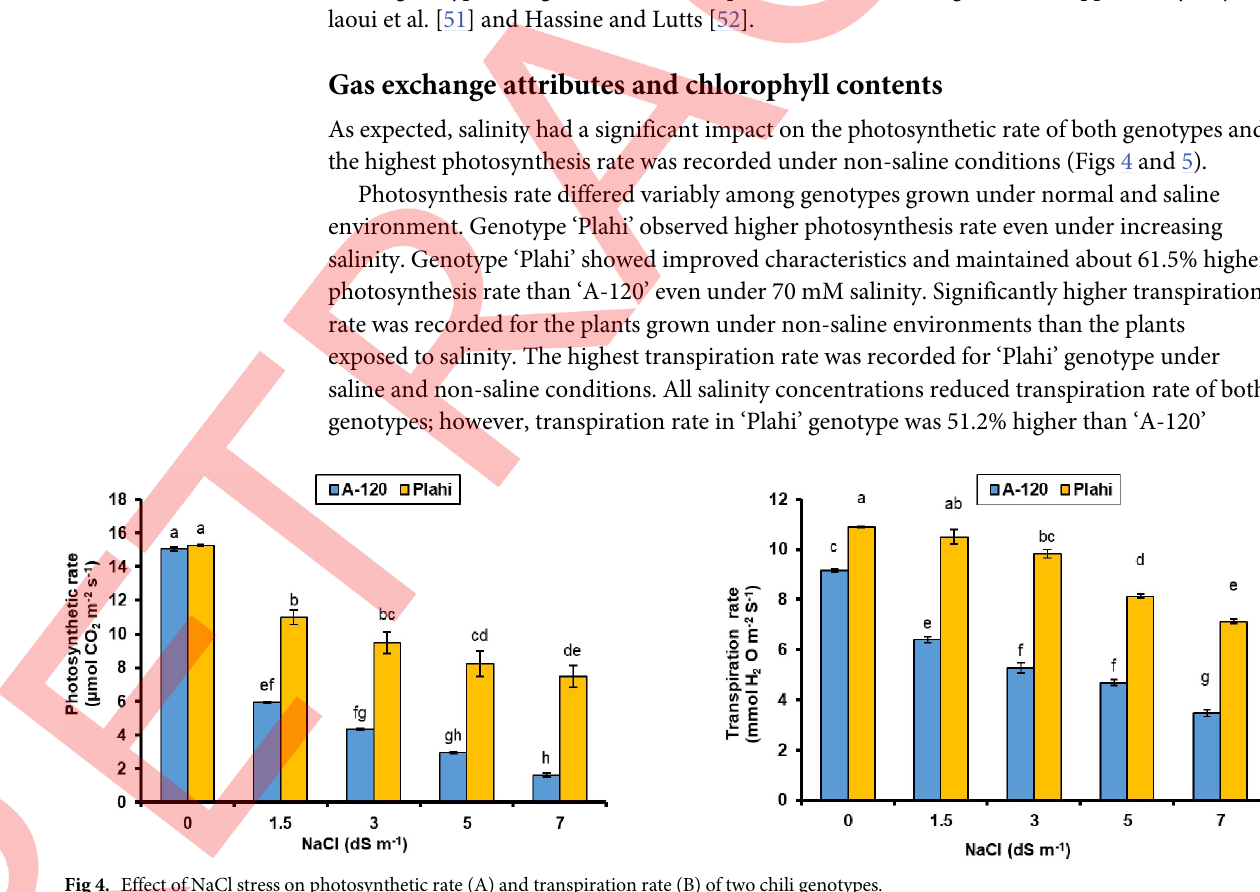
Fig 4. Effect of NaCl stress on photosynthetic rate (A) and transpiration rate (B) of two chili genotypes.